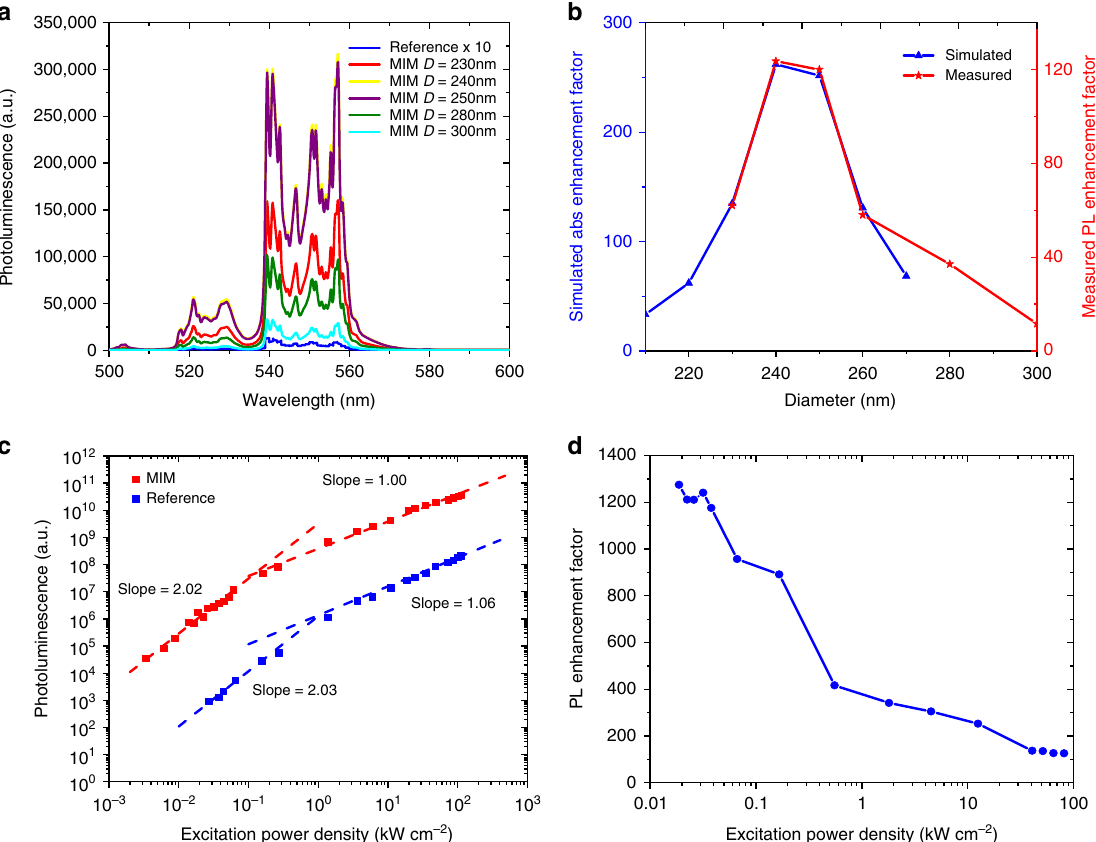
Fig. 3 Steady state photoluminescence (PL) spectroscopy results. a Green emission spectra of reference sample and metal – insulator – metal (MIM) structure of varying diameter under 980 nm excitation. The reference sample emission is magni fi ed by 10 to show the relevant features. b Measured versus simulated enhancement at 980 nm for MIM structures of various diameters. The measured enhancement is lower due to metal quenching and roughness but the overall diameter dependence agrees with predictions from simulation. c Upconversion luminescence intensity as a function of power density for 250 nm diameter MIM sample and the reference sample. Both samples show linear dependence at strong excitation power densities and quadratic dependence at weak excitation power densities which is expected from the nonlinear upconversion process. d 250 nm diameter MIM PL enhancement as a function of power density. At strong and weak excitation power densities, the enhancement plateaus as the PL scales identically for the reference and